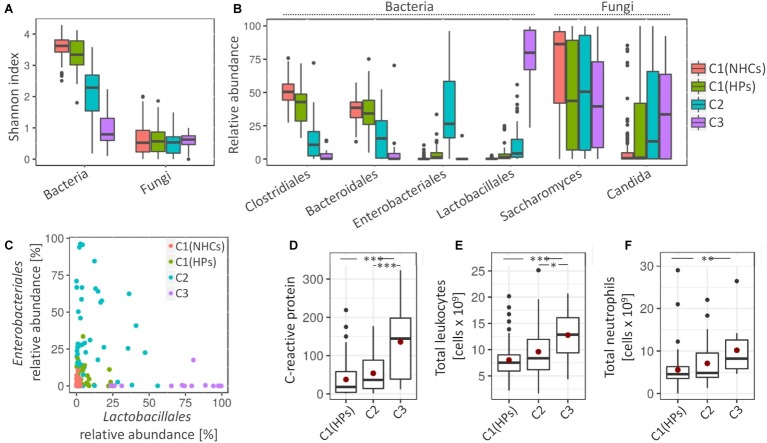
Cluster-specific bacterial and fungal patterns and degree of inflammation. (A) Shannon diversity index for bacterial and fungal communities. (B) Average relative abundance of four most represented bacterial orders and two most represented fungal genera. (C) The relative abundance of Enterobacteriales against relative abundance of Lactobacillales. Coloring in the subsections (A–C) denote cluster affiliation. (D–F) Measured inflammation markers, i.e., C-reactive protein (CRP) (D), total number of leukocytes, (E) and total number of neutrophils (F). Mean values are highlighted with a red dot. Asterisks denote the significance, at which the distributions differ among the compared groups.